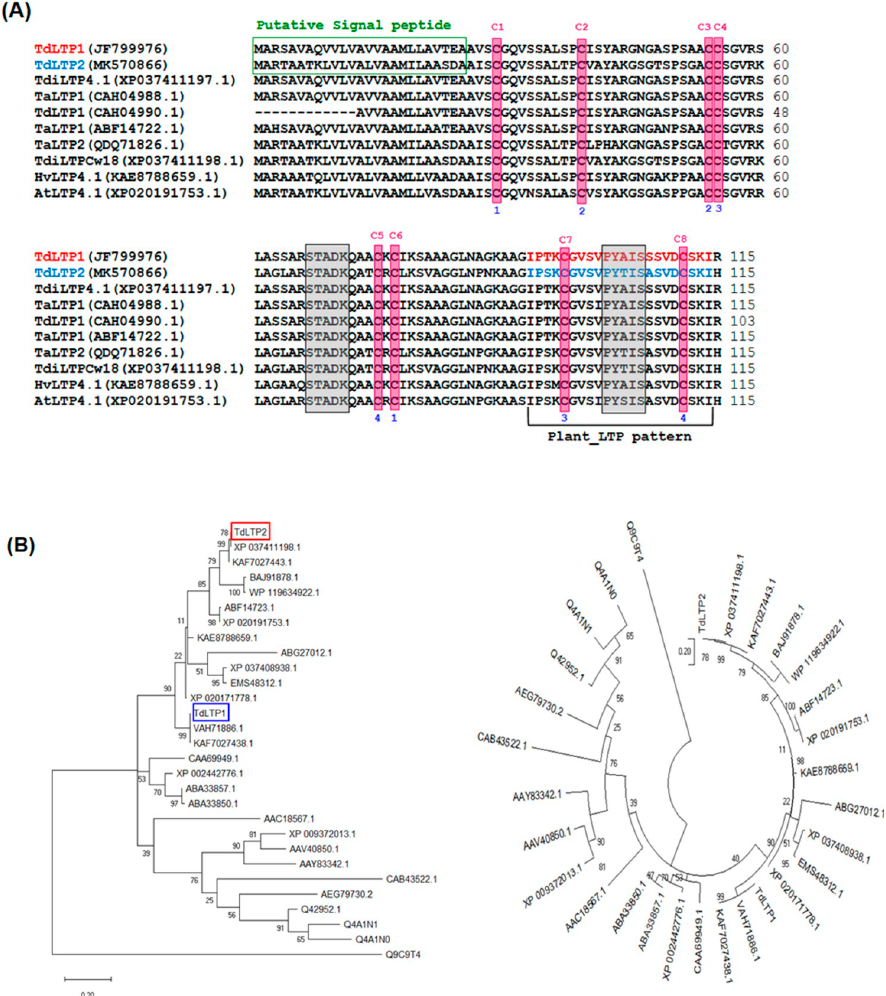
Fig 1. Sequence analysis of the wheat TdLTP2. Pattern and signature as revealed by ScanProsite tool with multiple alignment analysis of closed nsLTPs (A) and Molecular phylogenetic analysis of TdLTP2 sequence, with the reference TdLTP1 protein, by Maximum Likelihood method using MEGA.X program (B). The eight conserved cysteines are highlighted by magenta; the connections between the four disulfide bonds are marked by colored numbers; the two conserved pentapeptides are highlighted by